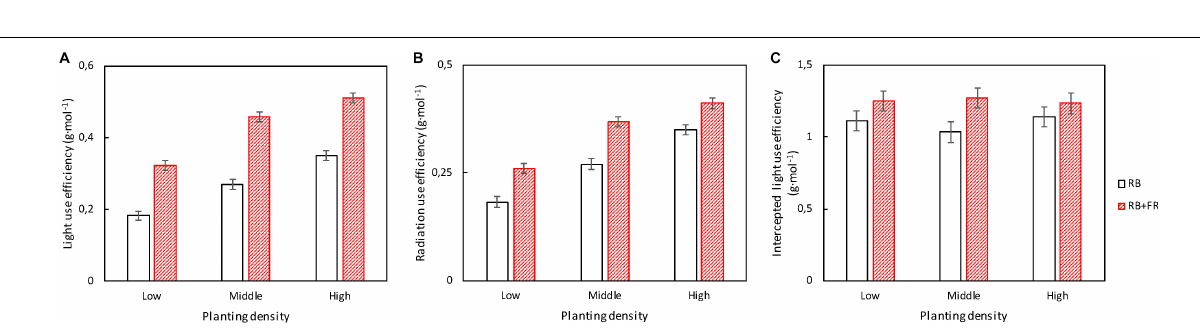
FIGURE 6 | (A) Incident light use efficiency [LUE inc , which is plant dry weight per unit of incident photosynthetically active radiation (PAR)]; (B) radiation use efficiency [RUE, which is plant dry weight per unit of incident radiation including PAR and far-red radiation (FR)]; and (C) intercepted light use efficiency [LUE int , which is the plant dry weight per unit of canopy-intercepted photosynthetic photon flux density (PPFD)] of lettuce plants grown at three planting densities (23, 37, and 51 plants m − 2 ), with (52 µ mol m − 2 s − 1 ) and without FR at 28 days after transplanting (DAT). Error bars indicate standard errors of means. None of these three parameters showed a significant interaction between FR and planting density ( P > 0.25). For incident light use efficiency (A) and radiation use efficiency (B) , effects of both FR [least significant difference (LSD) = 0.024 and LSD = 0.022, respectively, n = 3] and planting density (LSD = 0.030 and LSD = 0.027, respectively, n = 2) were significant ( P < 0.001). For intercepted light use efficiency (C) , planting density effect was not significant ( P = 0.87) and FR effect was significant ( P = 0.043; LSD = 0.15; n = 2). Data are means of two ( n = 2) or three blocks ( n = 3) each with four–six replicate